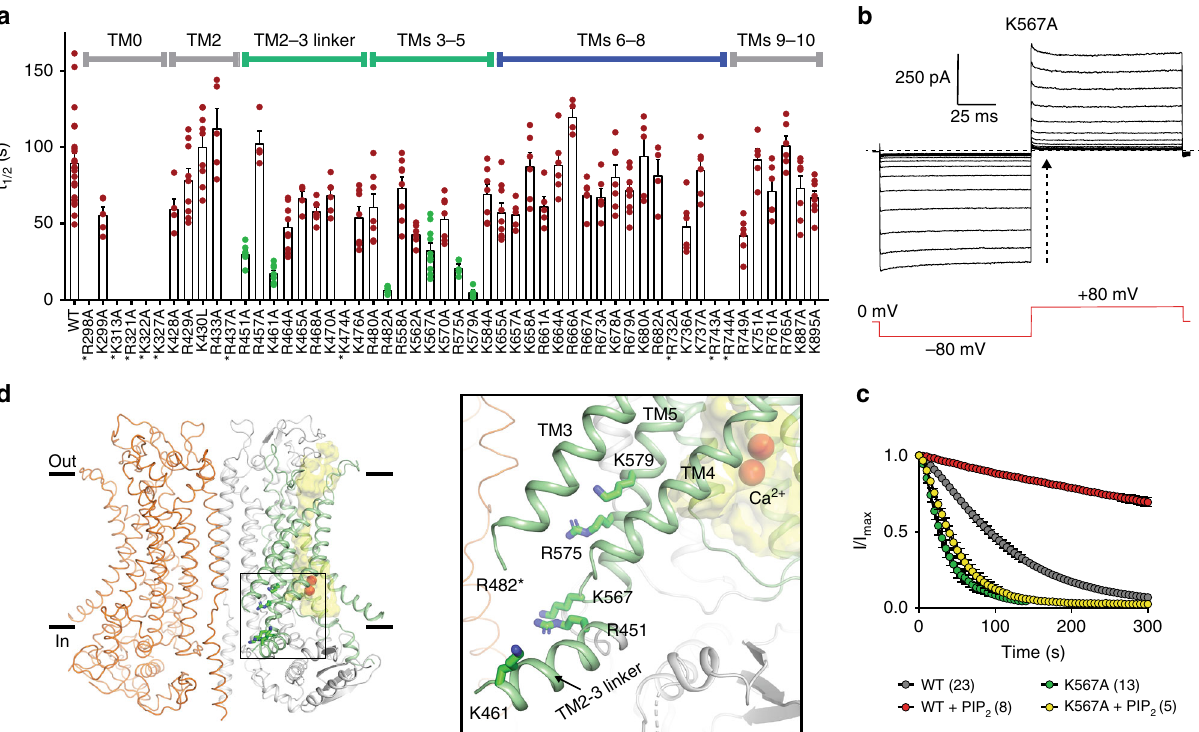
Fig. 3 Systematic alanine scanning identi fi ed six basic residues critical for TMEM16A desensitization. a Summary of alanine mutagenesis screen of basic residues situated at the inner membrane and cytosol interface and their half-decay ( t 1/2 ) values under 100 µ M intracellular Ca 2 + . The mutants exhibiting strongly accelerated desensitization rates are highlighted as green data points, including R451A, K461A, R482A, K567A, R575A, and K579A. Mutants that elicited negligible currents due to loss of function or surface expression are marked with an asterisk. n ranges from 4 to 23 individual recordings for each mutant. b Representative current traces of K567A under saturating 100 µ M Ca 2 + . Currents were elicited by the voltage protocol shown in inset at a 5-s interval. c Average normalized currents of K567A in the presence of 100 µ M Ca 2 + (green data points) or in the presence of 20 µ M diC 8 PIP 2 and 100 µ M Ca 2 + (yellow data points). WT TMEM16A ’ s desensitization (gray) and its response to 20 µ M diC 8 PIP 2 (red) are shown as controls. Numbers in parentheses denote the number of individual recordings. d Relative positions of the putative PIP 2 binding residues (green sticks). The ion permeation pathway is shown as yellow surface and the bound Ca 2 + ions are shown as red spheres. R482 is marked with an asterisk as it is not resolved in the cryo- EM structure (PDB 5OYB). Data are mean ± s.e.m. Source data are provided as a Source Data fi